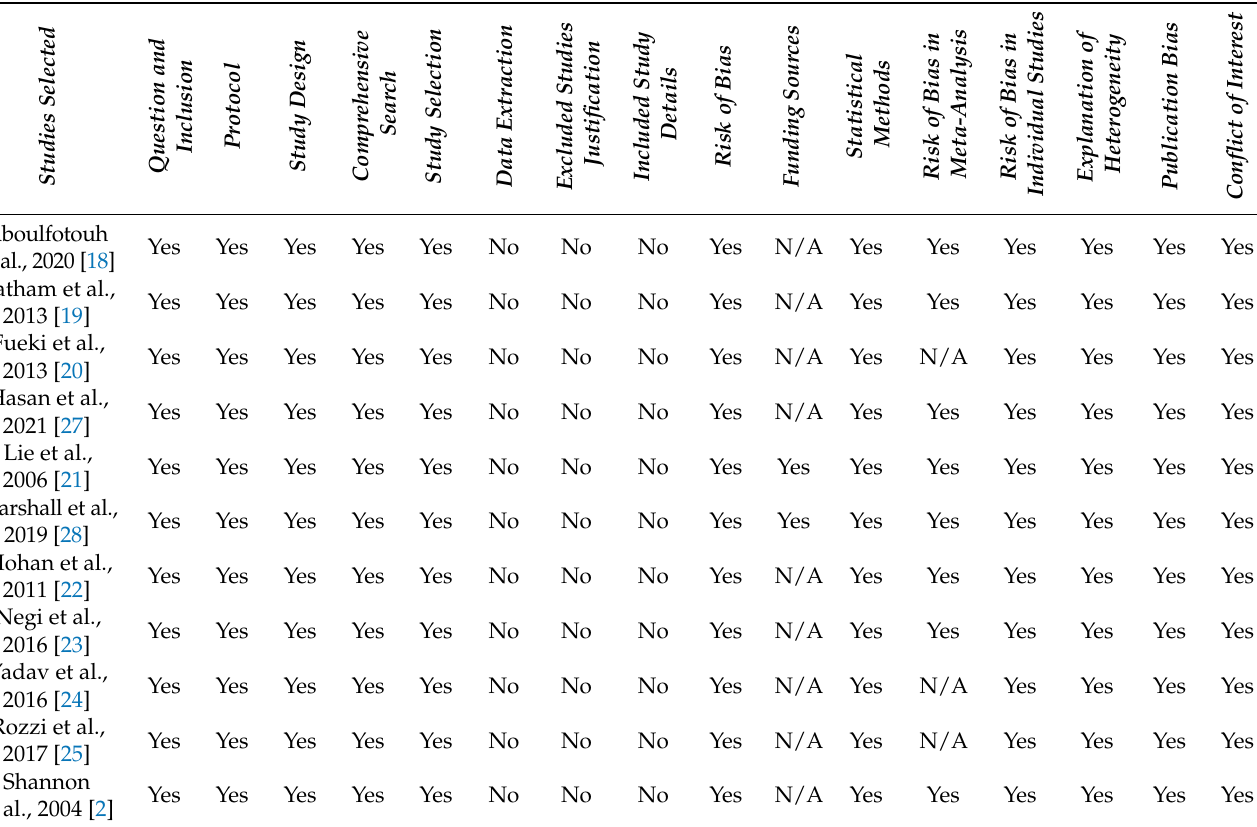
Table 1. AMSTAR-2 16-point checklist of risk of bias assessment in studies selected for the review.